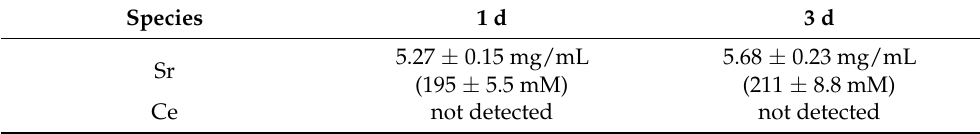
Table 1. Dissolved ion concentrations from S 2 Ce cement (W/P = 0.4) after 1 d and 3 d